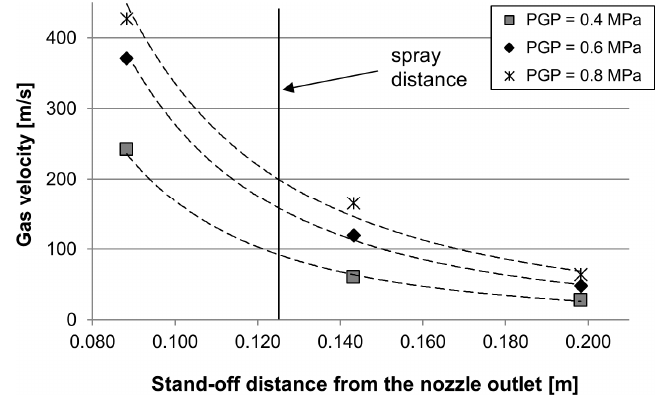
Figure 11. Differential pressure flow measurement, showing the gas velocity measured at different axial positions.